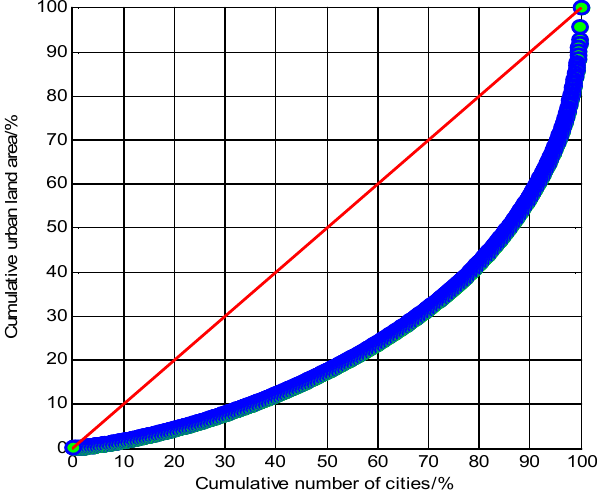
Figure 8. Lorenz curve of the distribution of urban systems in China during the TCE (The red line represents the uniform distribution of cities in the urban system. The blue dot represents the cumulative number of cities and cumulative urban land area in TCE).